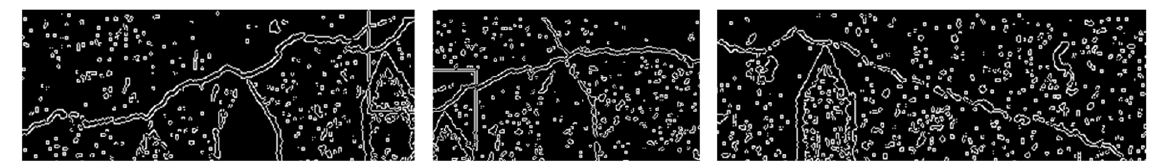
Figure 18. Canny edge detection outcome.